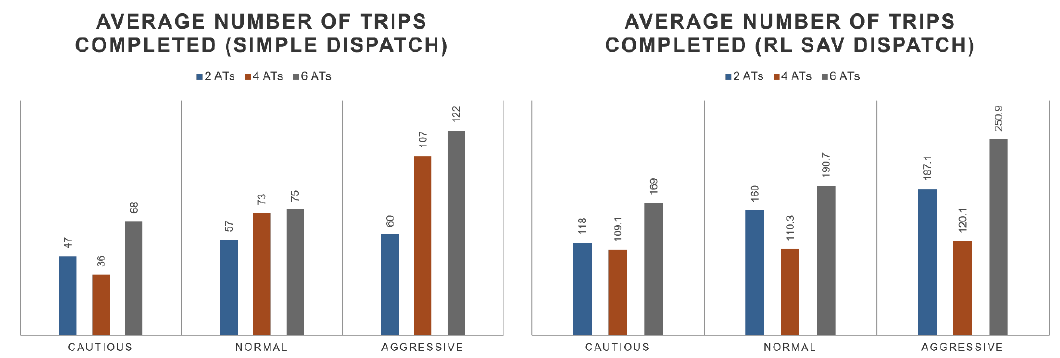
Figure 20. Number of trips of simple dispatcher vs. SAV dispatcher.